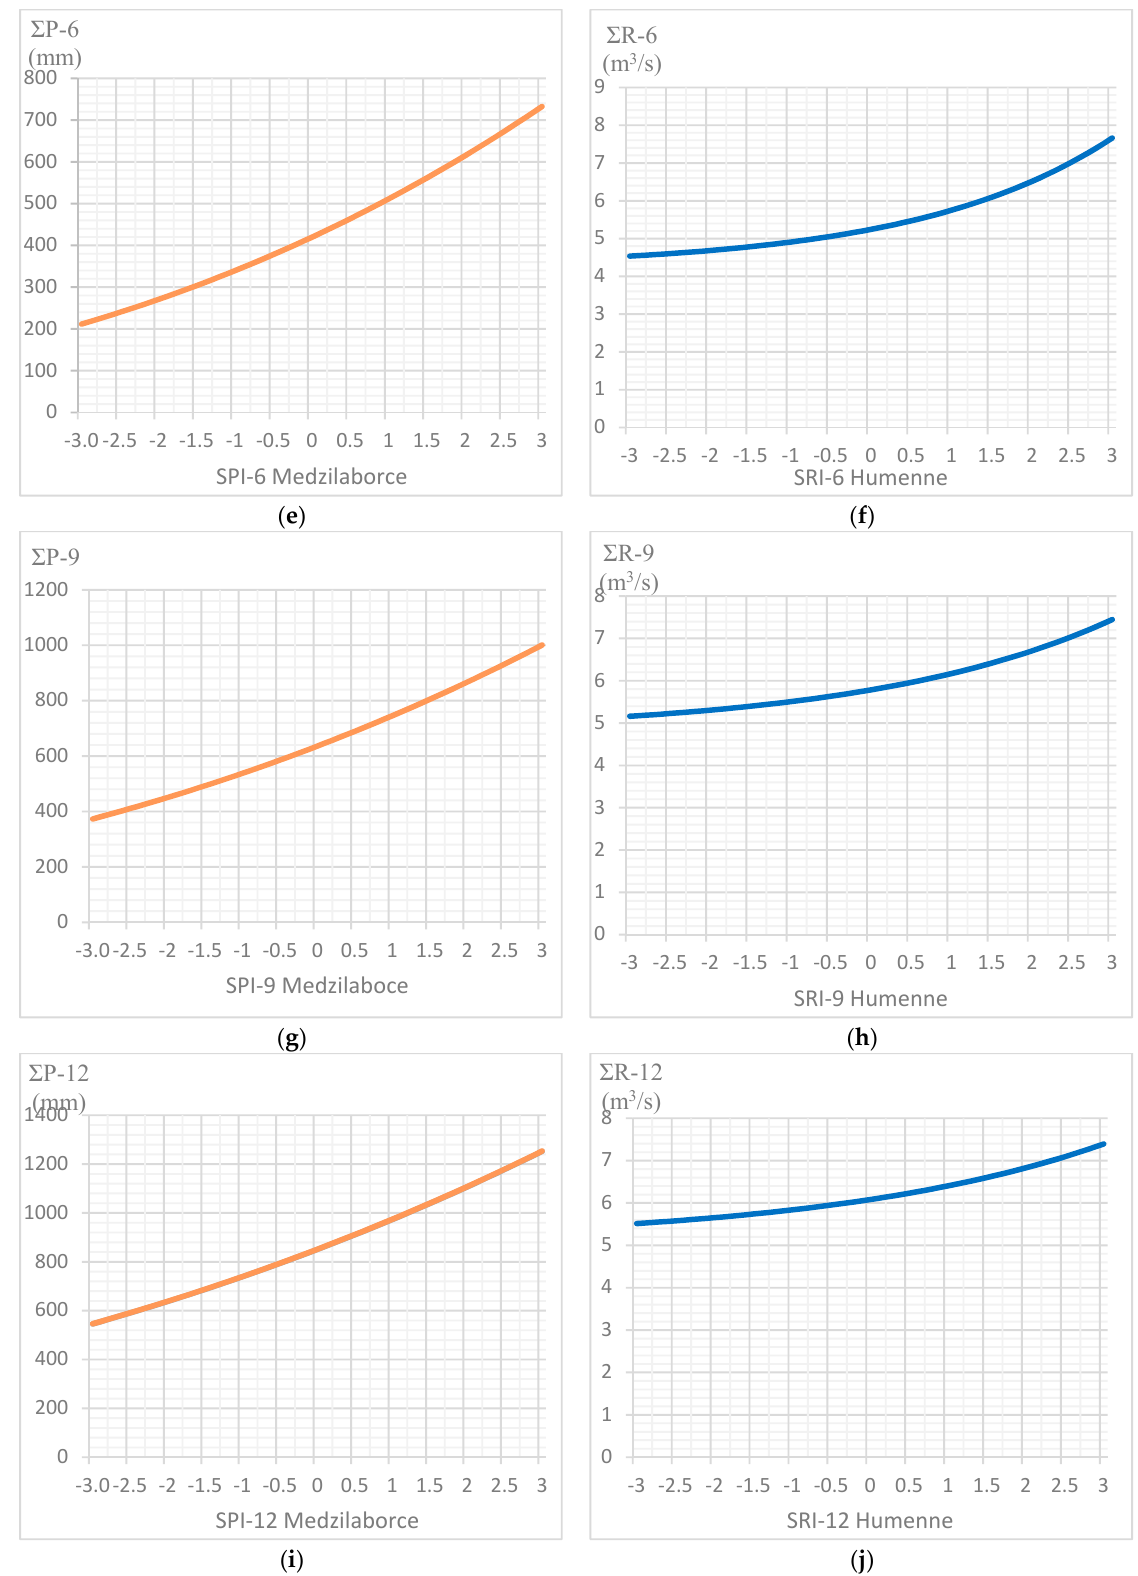
Figure 7. Example of nomograms for determining meteorological droughts for the Medzilaborce meteorological station and determining hydrological droughts for the Humenne hydrological station. ( a ) Σ P-1 and SPI-1 ( b ) Σ R-1 and SRI-1 ( c ) Σ P-3 and SPI-3 ( d ) Σ R-3 and SRI-3 ( e ) Σ P-6 and SPI-6 ( f ) Σ R-6 and SRI-6 ( g ) Σ P-9 and SPI-9 ( h ) Σ R-9 and SRI-9 ( i ) Σ P-12 and SPI-12 ( j ) Σ R-12 and SRI-12.